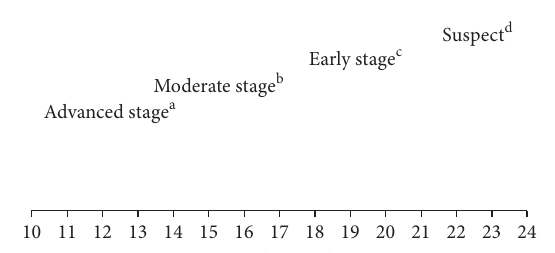
Figure 3: Suggested range for initial target IOP for each eye (a) with ≥ 30% reduction from baseline; (b) with 30% to 35% reduction from baseline; (c) with ≥ 25% reduction from baseline; (d) with ≥ 20% reduction from baseline. In patients with severe optic nerve damage, those with rapidly progressing disease or with other risk factors (i.e., family history, advanced age, pseudoexfoliation, pigment dispersion syndrome, uveitis, steroid use, or disc hemorrhage), selecting target IOP lower than 25% of the pretreatment IOP is justified. Other factors such as the rapidity of progression and the severity of disease in the other eye should be taken into consideration. Conversely, choosing a less aggressive IOP range may be reasonable if the risks ofaggressivetreatmentoutweighthebenefits(i.e.,comorbiditiesand older